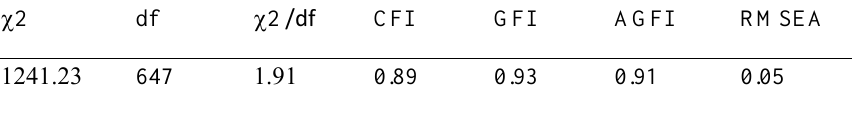
Model fit indexes of path